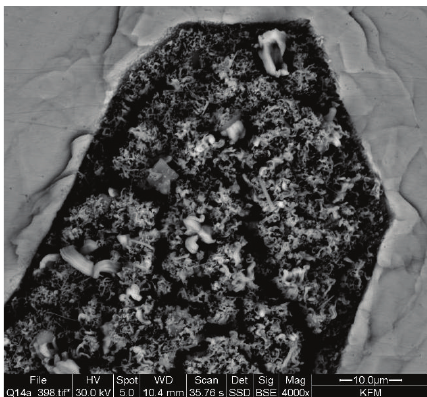
Figure 16: Point analysis of solder matrix in Al 2 O 3 /Sn2La solder